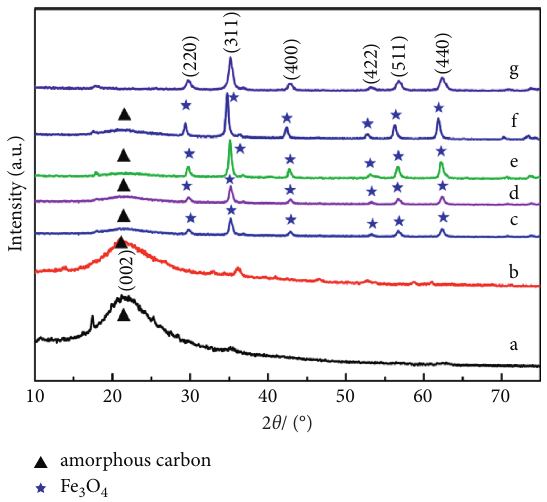
Figure 2: XRD pattern of S1 (a), S2 (b), S3 (c), S4 (d), S5 (e), S6 (f), and Fe